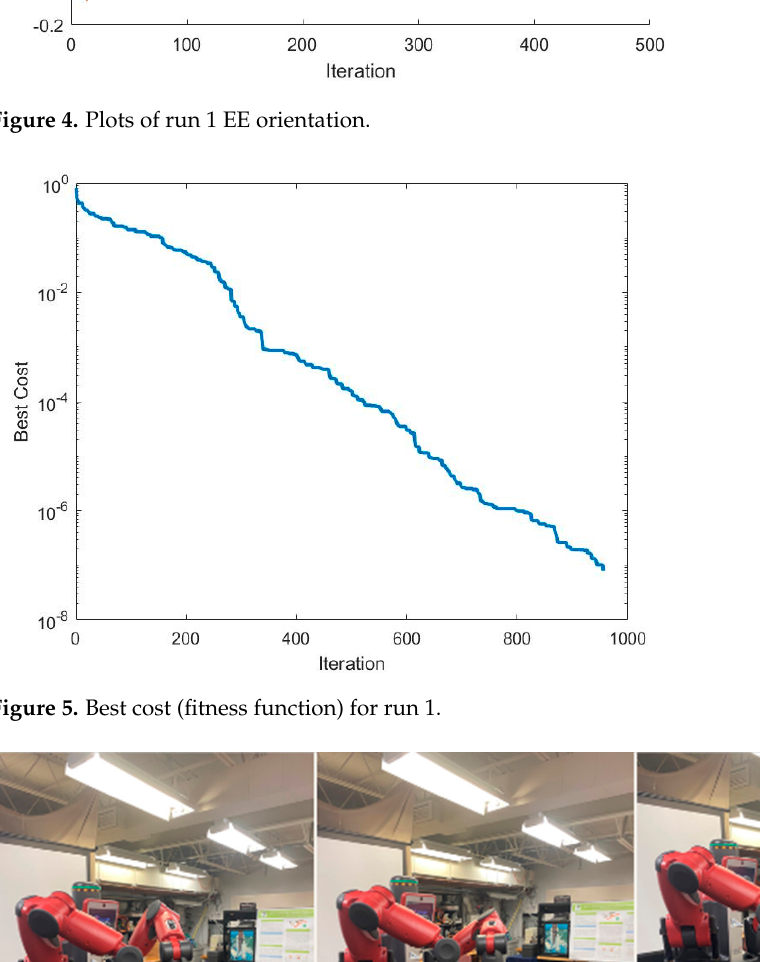
Figure 7. Baxter’s left − arm joint angles in the default untuck joint con fi guration obtained by se tt ing 𝜃 (cid:3038)(cid:3031)(cid:3032)(cid:3046) = 59.014°. 6. Parallel Processing of the PSO Algorithm The results described in the previous section were obtained with the inverse kine- matics algorithm implemented using MATLAB, a mathematically convenient but not nec- essarily a time e ffi cient language for this type of problem. In an e ff ort to improve the speed of execution, the algorithm was implemented using Portable Operating Interface (POSIX) threads, commonly called pthreads which are executed in parallel. Idealistically, if there are enough processors, each particle dynamic computation can be programmed into one pthread which runs on one processor. A variety of test runs were performed using a lap- top computer with 21 processors to evaluate the speed of convergence as shown in Tables 3–4. The parallel processing fl owchart is shown in Figure 8. A brief description of the POSIX threads pseudo code is given below. Posix Threads A thread API based on standards for C/C++ is provided by the POSIX thread libraries. A new concurrent process fl ow may be spawned using it. It works best with systems that have several processors or cores, since the process fl ow can be scheduled to run on a dif- ferent processor, allowing for parallel or distributed processing to speed up the system. Each thread has a unique: • Thread ID